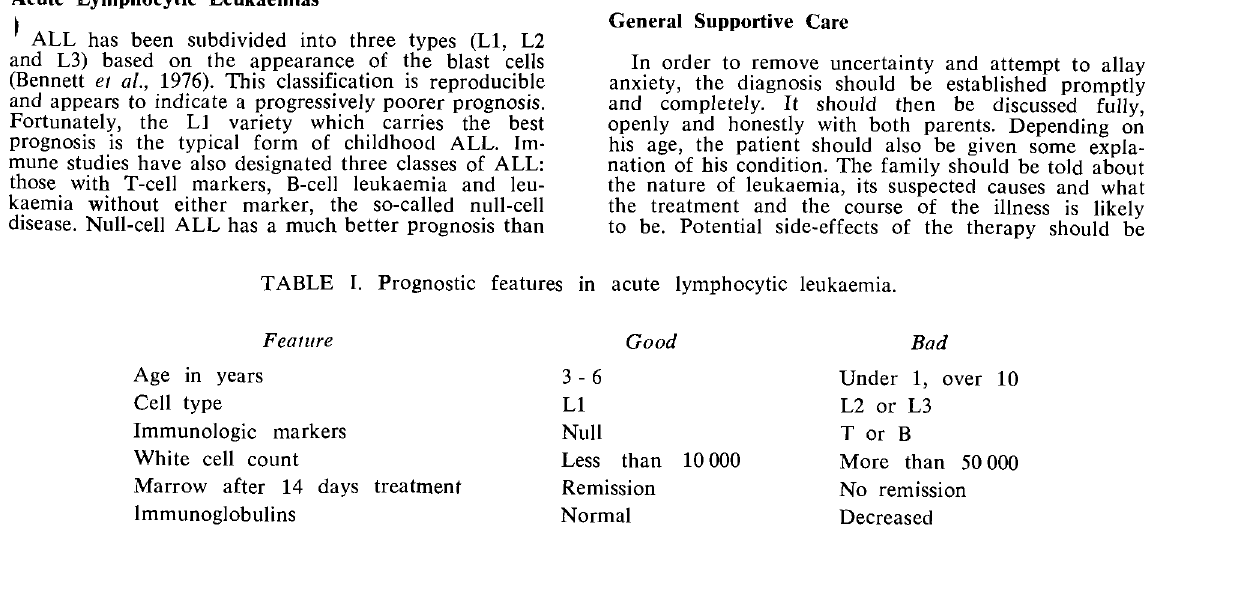
TABLE I. Prognostic features in acute lymphocytic